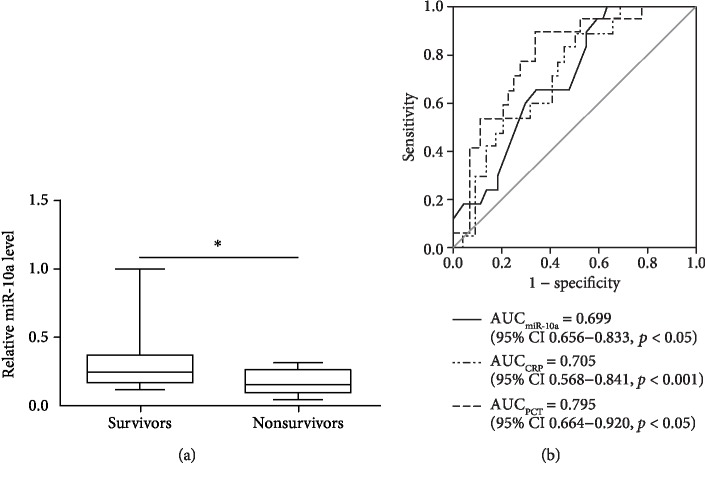
ROC curves for the prediction of 28-day mortality. (a) PBMC miR-10a levels were compared between nonsurvivors (n = 17) and survivors (n = 45). (b) ROC curves present sensitivity and specificity of PBMC miR-10a, CRP, and PCT for predicting 28-day mortality.